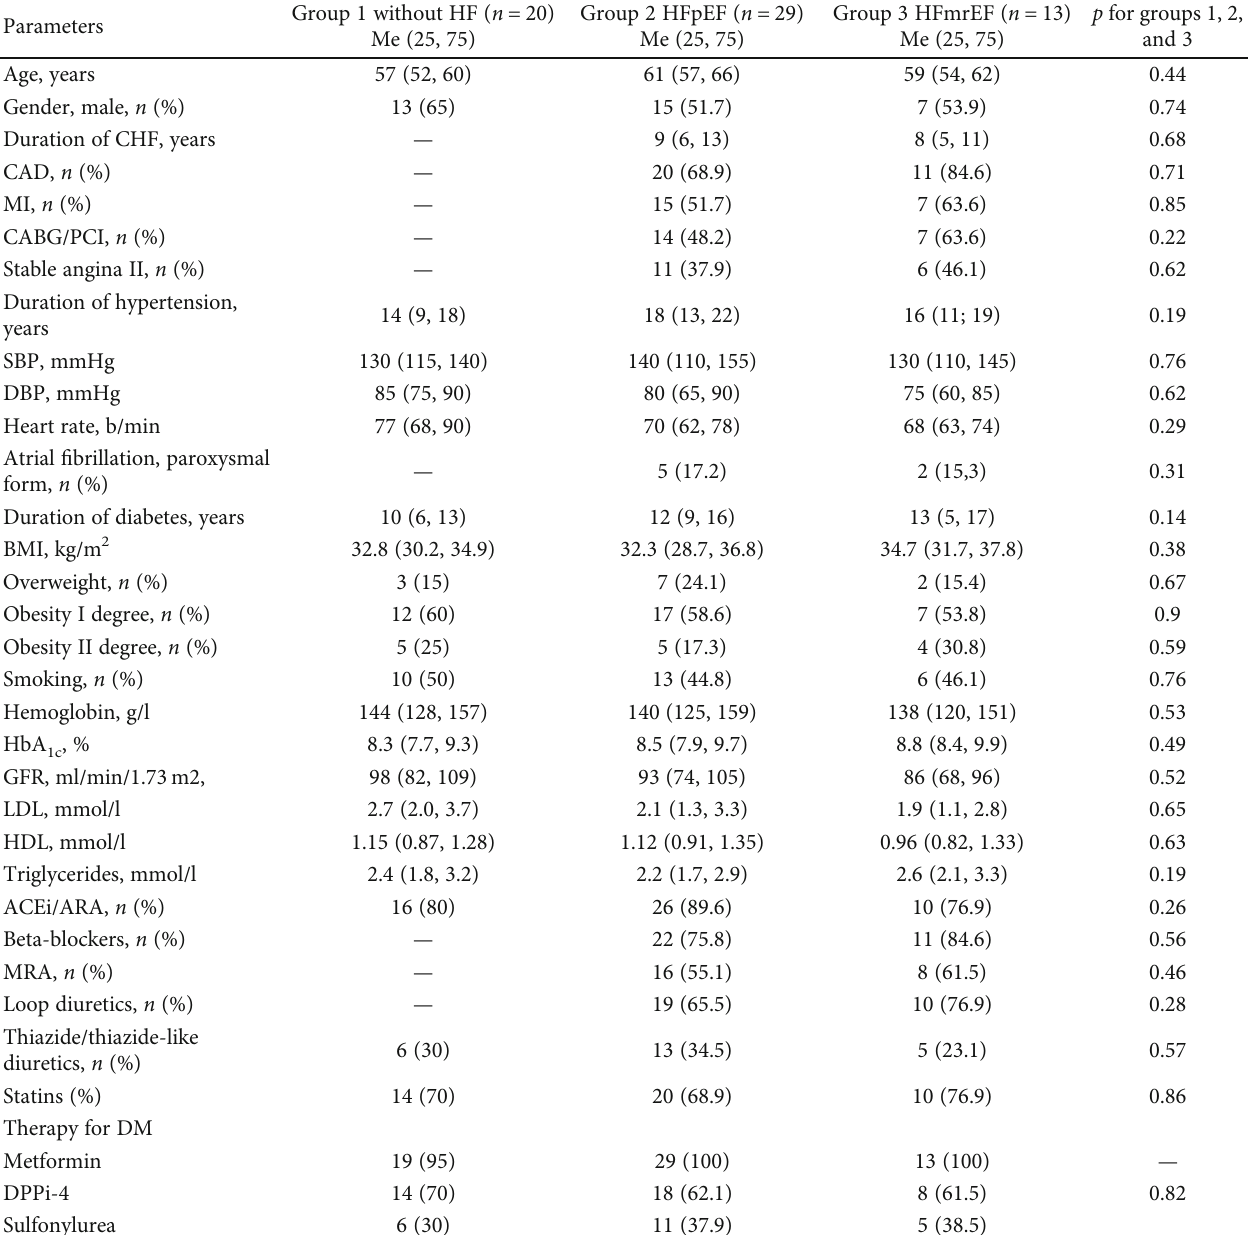
Table 1: Demographic and clinical characteristics of the